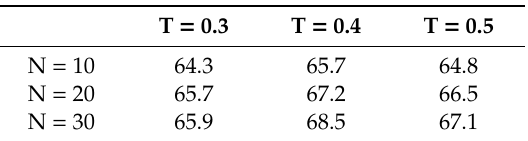
Table 3. Parameter